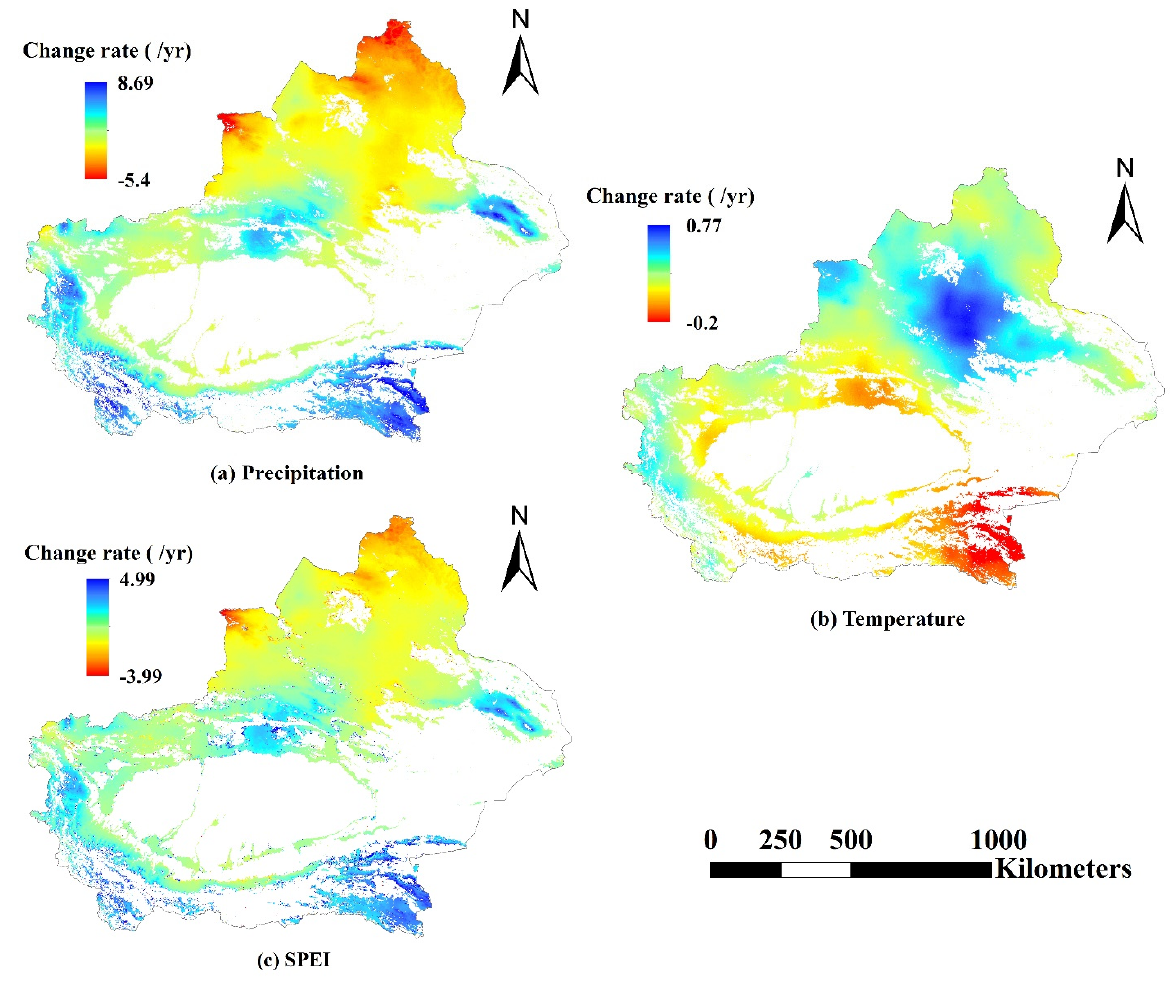
Figure 6. Spatial distribution of climate change rate for May to September of 2000 − 2019, ( a ) Change rate of annual precipitation accumulation, ( b ) Change rate of mean temperature, ( c ) Change rate of SPEI.